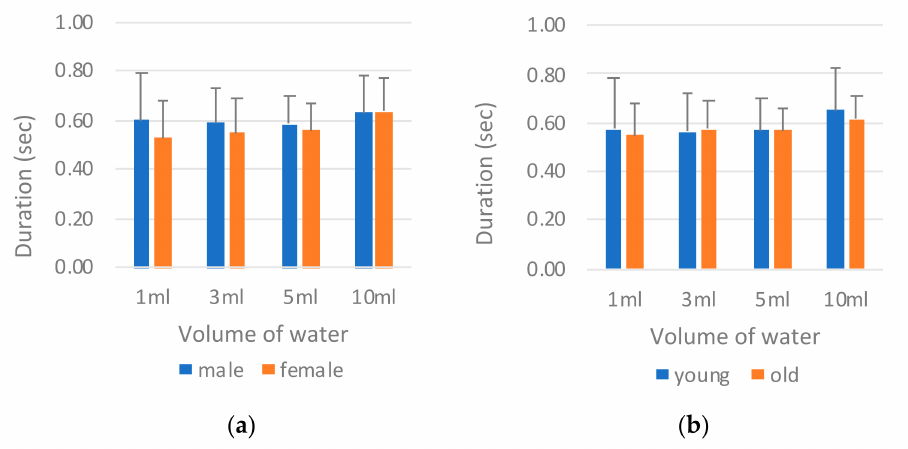
Figure 10. Comparison of nasal airflow pause duration T NAir by ( a ) sex and ( b ) age. Table 6. Analysis of variance results of the factors on nasal